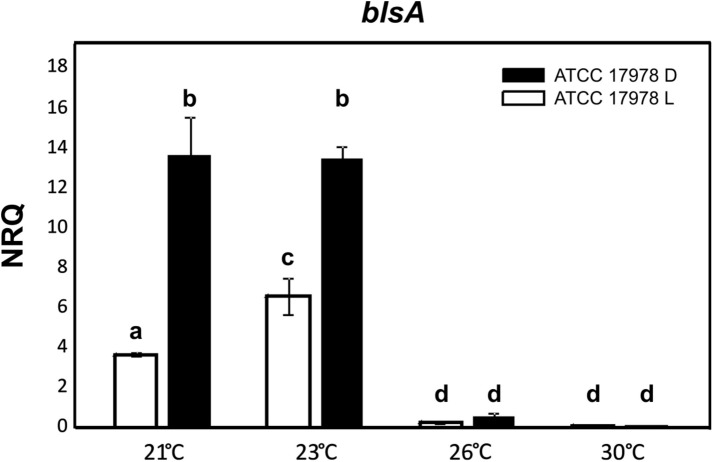
blsA expression levels follow photoregulation patterns. Estimation by RT-qPCR of the blsA expression levels in ATCC 17978 wild-type genetic background at different temperatures analyzed indicated in the x-axis, under blue light (L) or in the dark (D). The data shown are mean ± SD of normalized relative quantities (NRQ) obtained from transcript levels of blsA from cells recovered from motility plates incubated at the indicated temperatures under blue light or in the dark, measured in three biological replicates. Different letters indicate significant differences as determined by ANOVA followed by Tukey’s multiple comparison tests (p < 0.01).